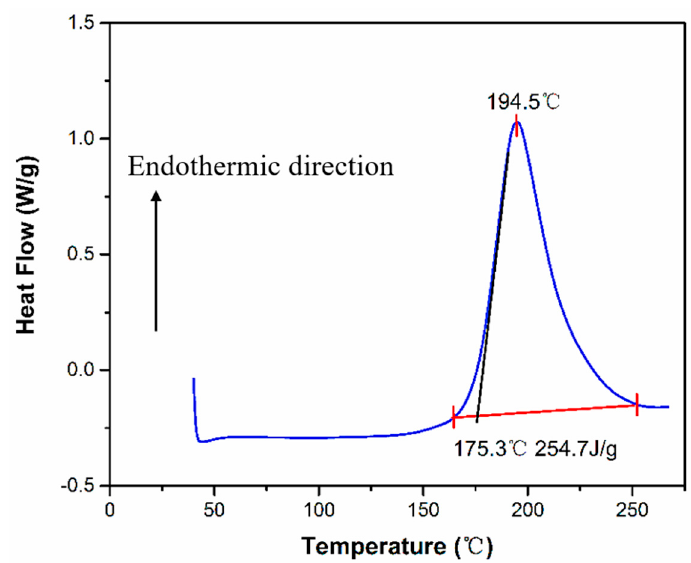
Figure 14. Differential scanning calorimetry (DSC) thermogram of the CFRP epoxy resin.